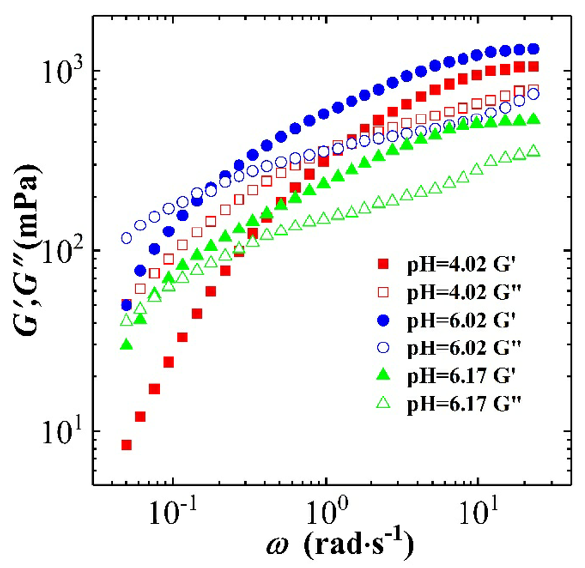
Figure 10. The dynamic rheological curves for the CTAB-MA based (30 mM CTAB + 15 mM MA) VES-fluid at pH range (4 < pH < 7) and at 25 ◦